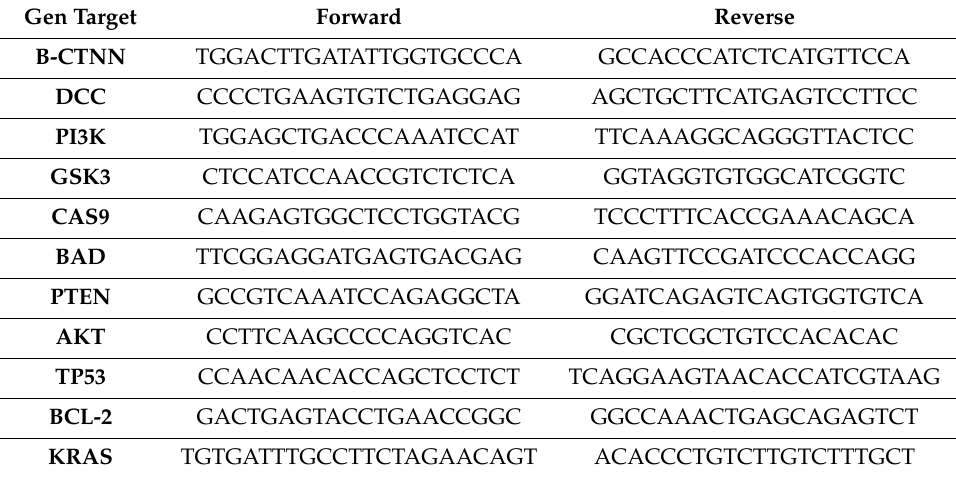
Table 2. Primer sequences for Real-Time Polymerase Chain Reaction